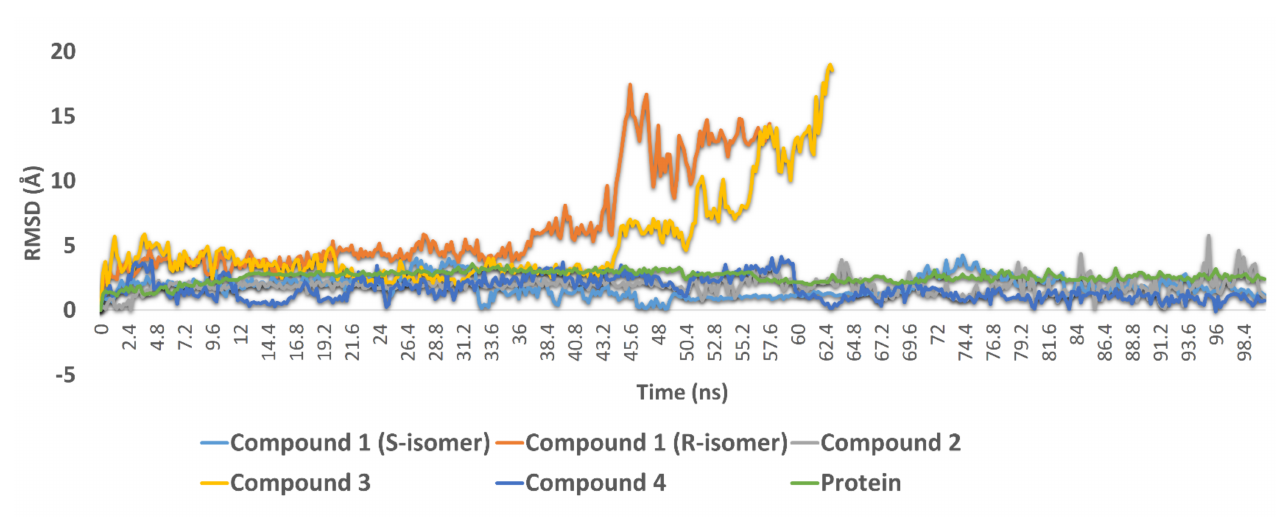
Figure 6. RMSDs of compounds 1 – 4 along with the free protein during the course of 100 ns.